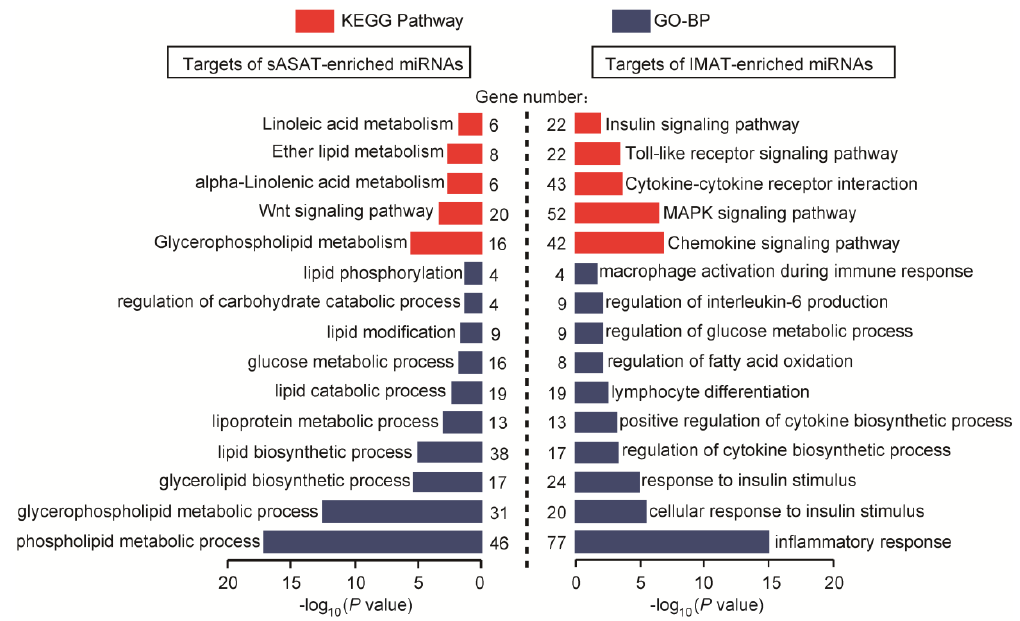
Figure 3. KEGG pathways and gene ontology biological process (GO-BP) categories enriched in the target genes of the top eight sASAT- and IMAT-enriched miRNAs. GO-BP is the GO terms under the biological process